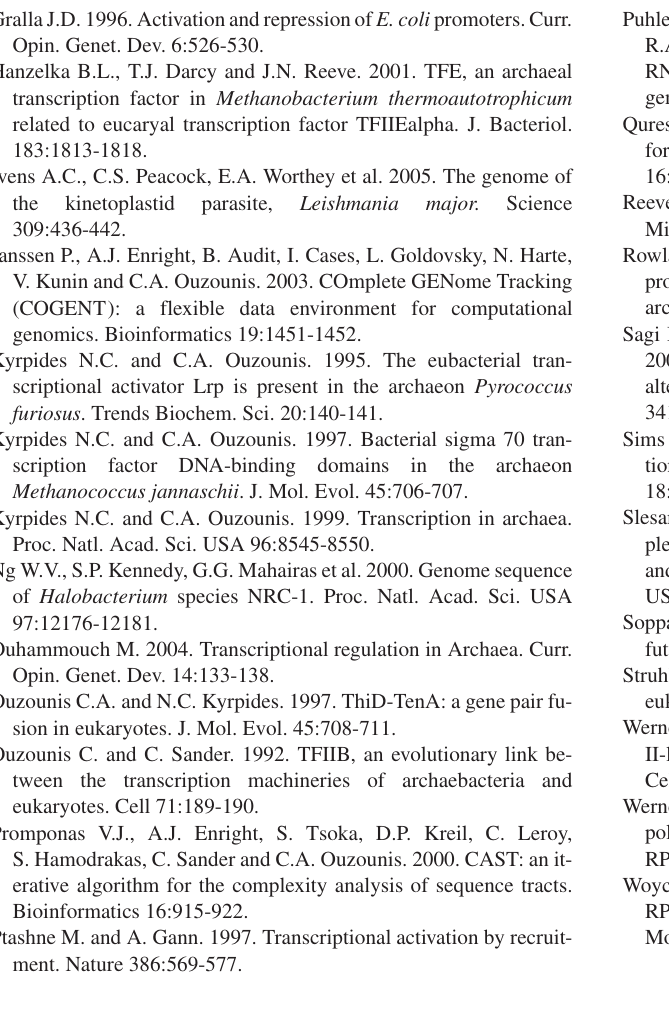
Table S1. Number of archaeal genes matching domains present in RNA polymerase subunits. Table S2. RNA polymerase subunit gene copy number in archaeal